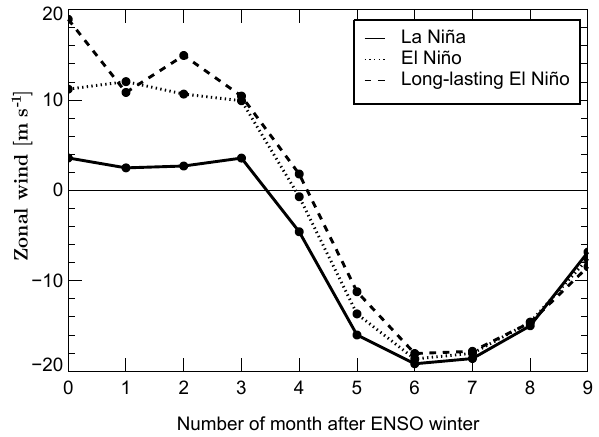
Figure 3. Mean zonal wind in the tropics over south-eastern Asia (5 ◦ –20 ◦ N, 40 ◦ –120 ◦ E) following La Niña, El Niño and long- lasting El Niño winters at 200hPa. The transition from positive to negative values marks the onset of the Asian summer monsoon (ASM). The zero mark on the x axis denotes the middle of the DJF season (i.e. 15